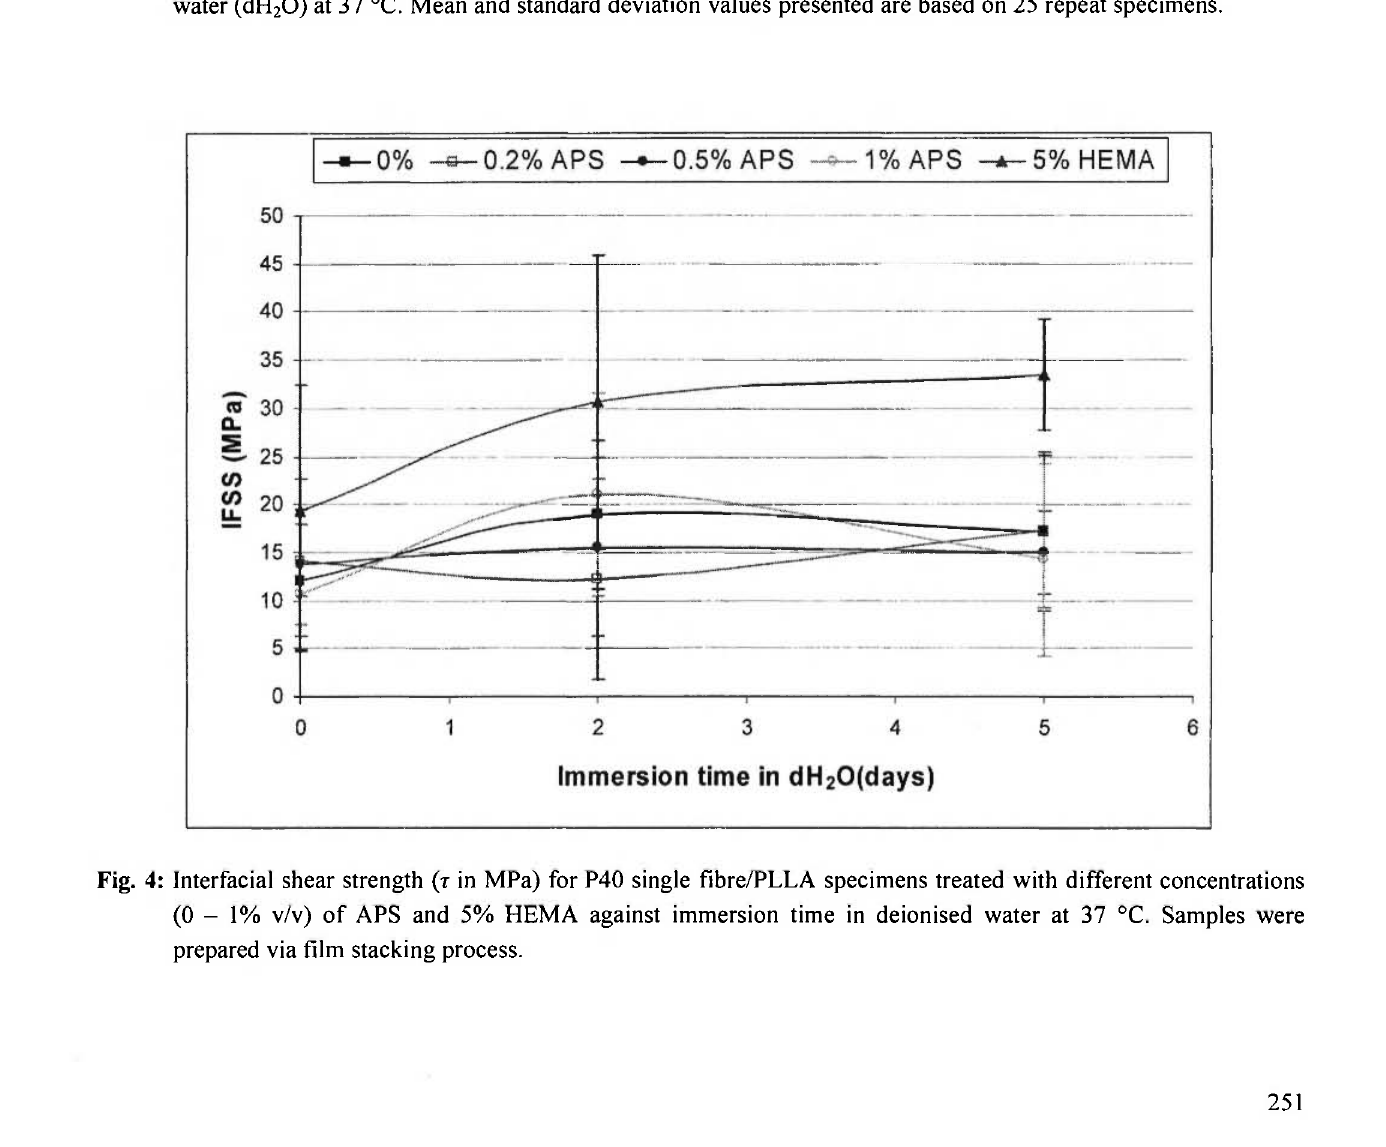
Fig. 4: Interfacial shear strength (r in MPa) for P40 single fibre/PLLA specimens treated with different concentrations (0 - 1% v/v) of APS and 5% HEMA against immersion time in deionised water at 37 °C. Samples